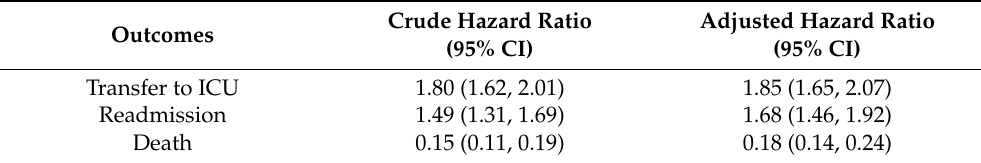
Table 3. Risk of hospital readmission and deaths in patients admitted to hospital with COVID-19 compared to pneumonia patients, NGHA, Saudi Arabia.